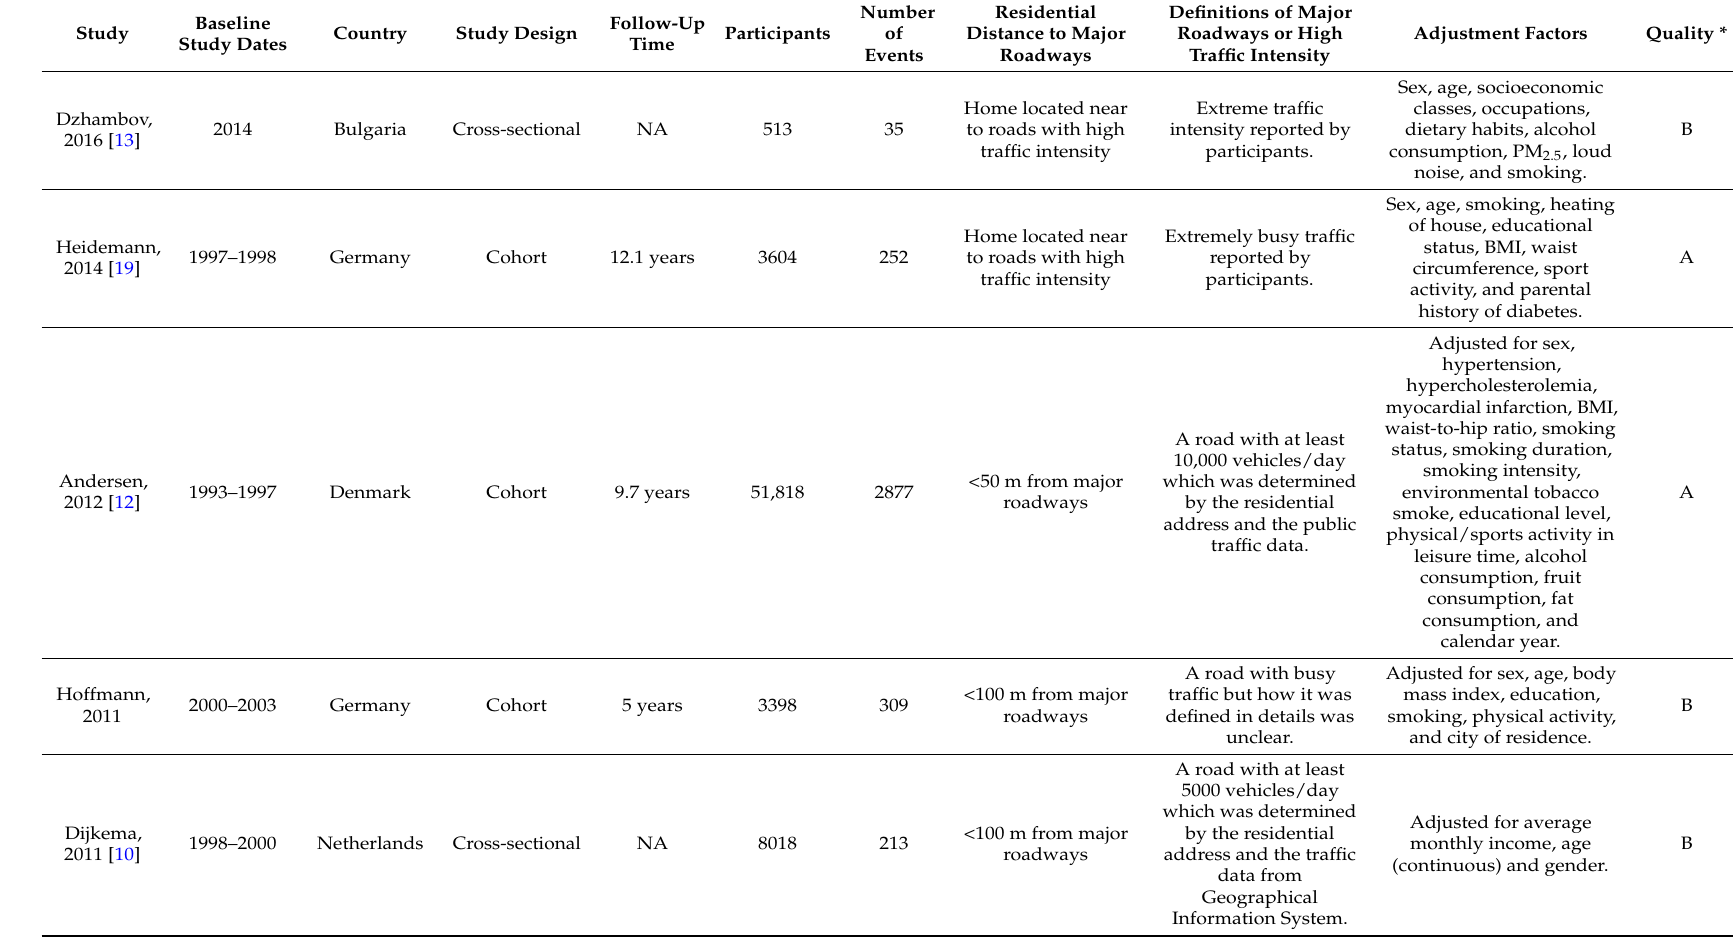
Table 1. Characteristics of seven included studies in the